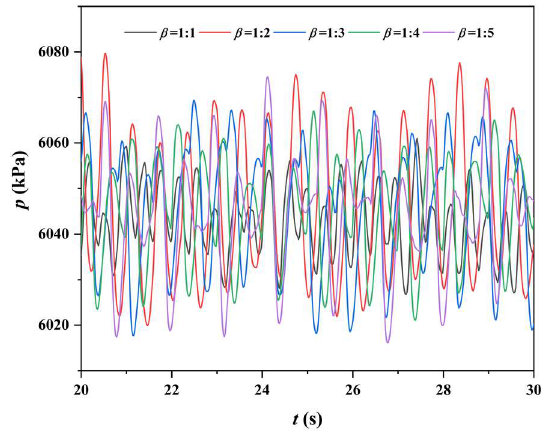
Figure 14. Comparison of the pressure ( p ) acting on Bend 3 at different gas-liquid ratios, where β is the gas-liquid ratio.